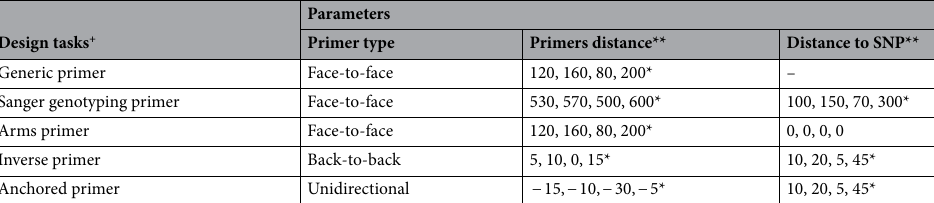
Table 1. Parameters used to implement different design tasks. + “Common Primer Type” is named in web- based interface. *The parameter value is a commonly-used example and it should be set according to the experimental requirement. **The parameter value consists of four comma-concatenated numbers, which are respectively the minimum and maximum of the optimal range, the minimum and maximum of the permitted range.